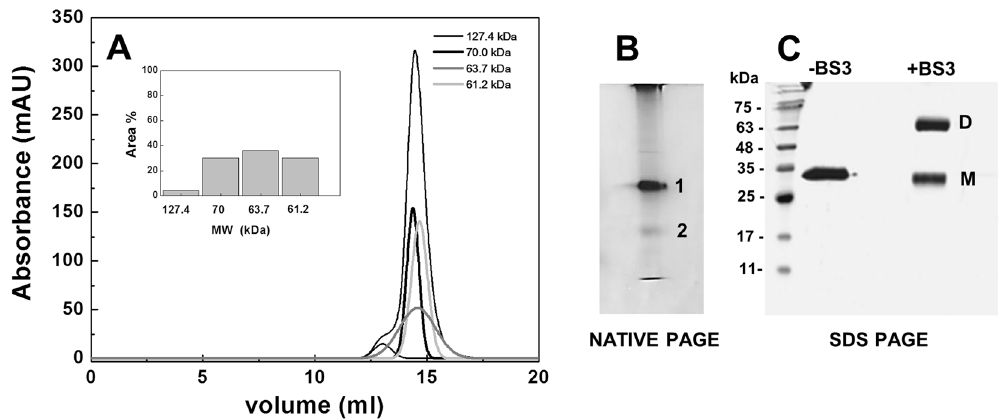
Figure 3. Hydrodynamic properties of Spn FADS. ( A ) Gel-filtration chromatogram of pure Spn FADS (20 µ M) using a precalibrated Superdex TM 200 10/300 GL column ( GE Healthcare ) equilibrated with 50 mM Tris/ HCl, pH 8.0, 150 mM NaCl, and calibrated with the Gel Filtration Calibration Kit LMW ( GE Healthcare ). The inset shows the percentage of the fractions obtained from the chromatogram. ( B ) 12% Native PAGE of pure Spn FADS. The two major bands are denoted by number; 1 for predicted oligomers and 2, the most populated, for the putative monomer. ( C ) 15% SDS-PAGE of Spn FADS without crosslinker and after incubation with